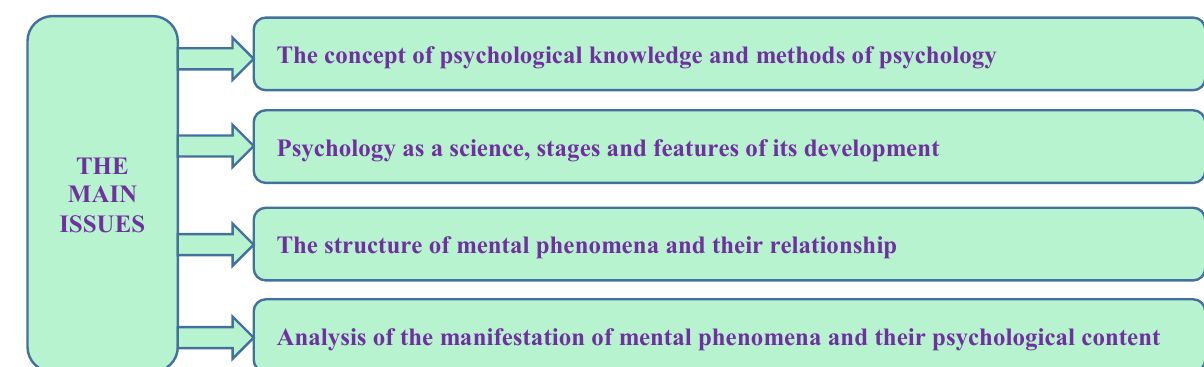
Figure 2. The main issues for the acquisition of knowledge of future specialists in applied behavioral